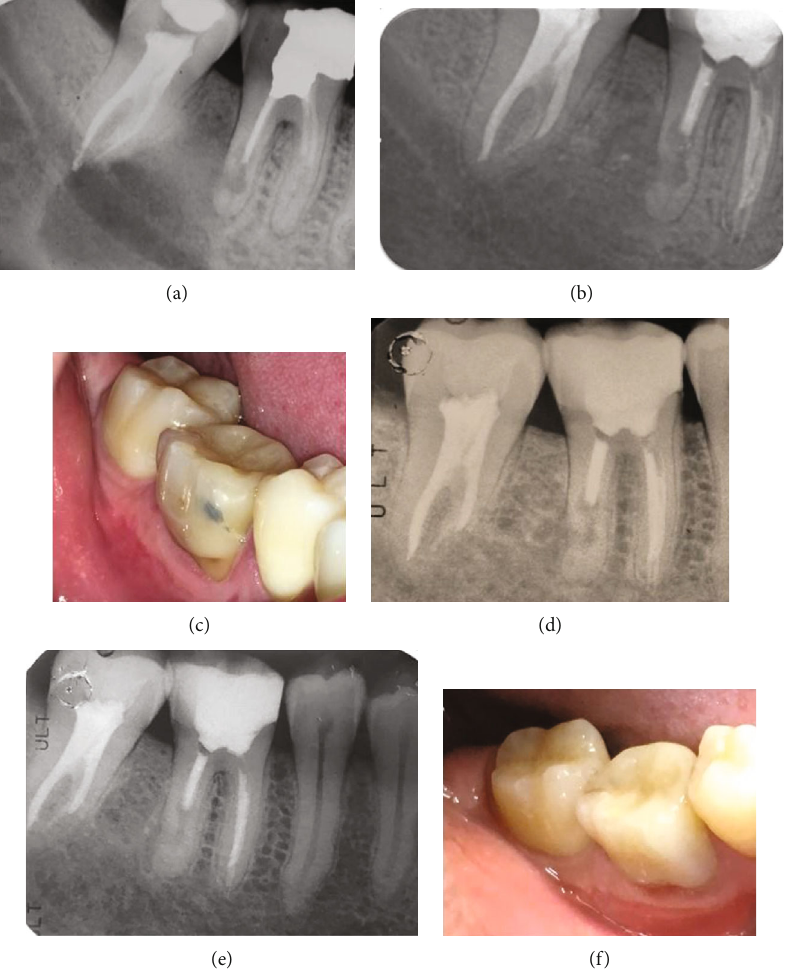
Figure 4: (a) Postoperative periapical radiograph showing root canal treatment of the second mandibular molar. (b) Four-month periapical radiograph showing an increase in radiopacity and trabeculae formation in the area of the intervention. (c) Four-month clinical photograph. (d) Two-year follow-up periapical radiograph. (e) Five-year follow-up periapical radiograph showing both repair of the distal root and bone healing. (f) Clinical photograph at the fi ve-year recall